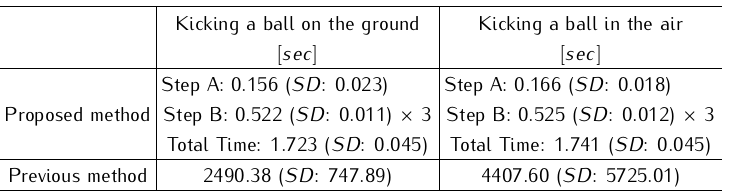
Table 2. Comparison of the computation time. In proposed method, the total computation time is calculated by the time for Step A + the time for Step B × iteration number. SD means standard